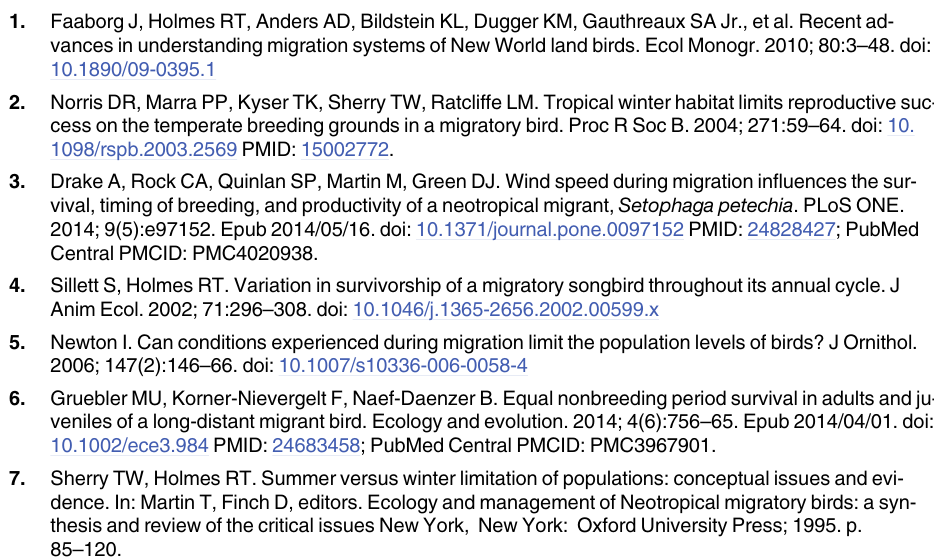
S1 Table. Detailed phenology data over the annual cycle for Barn Swallows fit with archival light-level geolocators from five populations, 2011 –